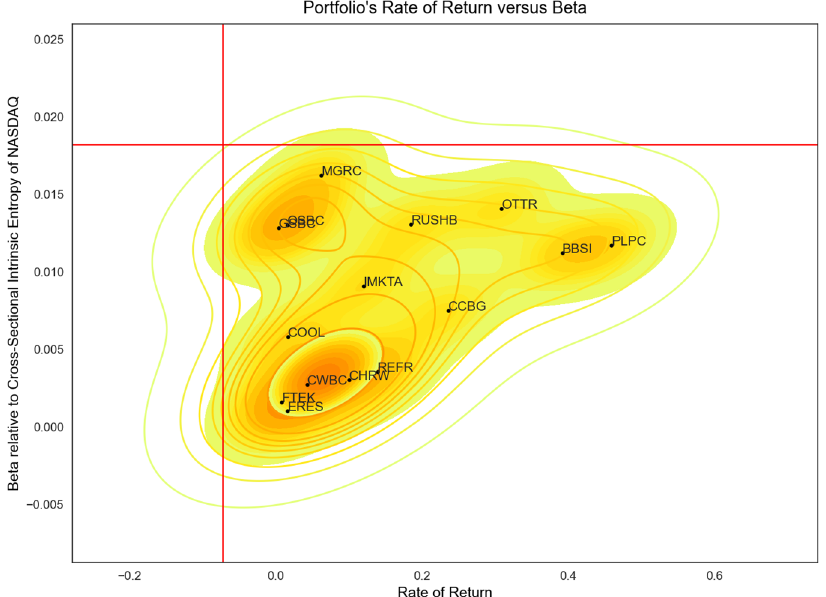
Figure A4. A set of 15 NASDAQ symbols that outperformed the Russell 2000 Composite index in terms of rate of return without being exposed to higher risk (125-day trading interval, from 1 March 2022 to 26 August 2022).